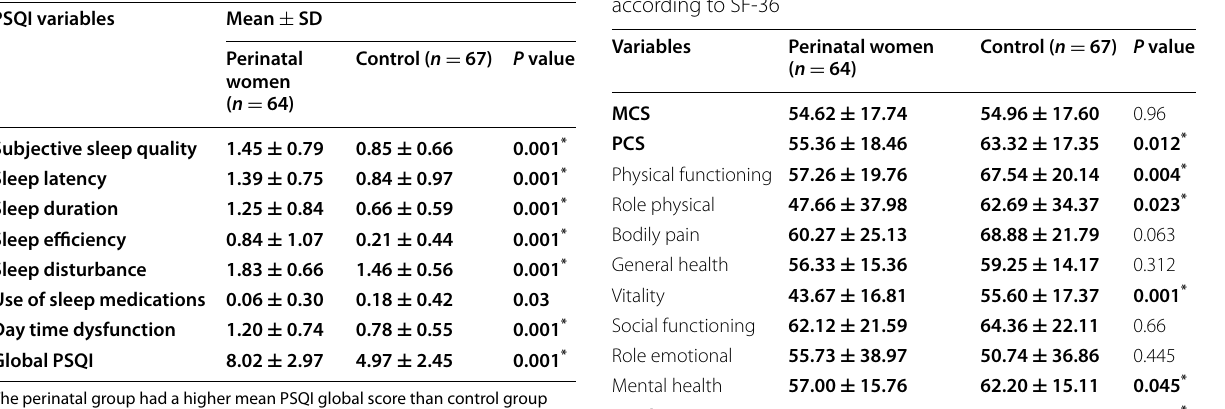
The perinatal group had a higher mean PSQI global score than control group indicating poorer sleep quality. This difference between the two groups was statistically significant. All components of the PSQI—except for the use of sleep medication—were statistically different between the two groups ( p < 0.05). The perinatal group had higher scores—except for the use of sleep medication— with the highest score in the sleep disturbance component * P value < 0.05 in comparison with the control group